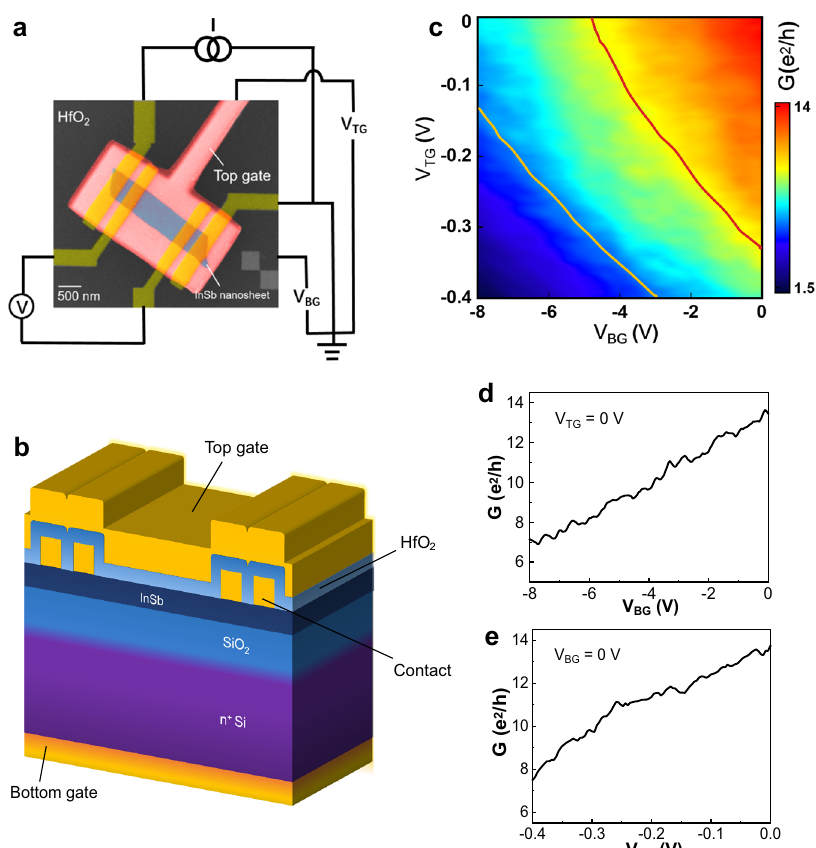
Fig. 1 Dual-gate InSb nanosheet device and its gate transfer characteristics. a False-colored SEM image of the device studied in this work and measurement circuit setup. The device is fabricated from an MBE-grown InSb nanosheet (transport channel) on an n-doped Si substrate (bottom gate) covered by a layer of SiO 2 on top (bottom-gate dielectric). The InSb nanosheet is contacted by four stripes of Ti/Au (contact electrodes) and is then covered by depositing a layer of HfO 2 (top-gate dielectric) and a metal bilayer of Ti/Au (top gate). The nanosheet has a width of ~550 nm and a thickness of ~30 nm. The separation between the two inner electrodes is ~1.1 μ m. b Schematic view of the layer structure of the device. c Conductance G measured for the device as functions of top-gate voltage V TG and bottom-gate voltage V BG (gate transfer characteristics) at a temperature of T = 1.9 K. In the measurements, a 17-Hz AC current ( I ) of 100 nA is applied through the two outer electrodes, and the voltage drop ( V ) between the two inner electrodes is recorded and is then converted to the conductance through G = I / V . The red and yellow solid lines denote the constant conductance contours of ~9 and ~5 e 2 / h , respectively. d G as a function of bottom-gate voltage V BG at V TG = 0 V. e G as a function of top-gate voltage V TG at V BG = 0